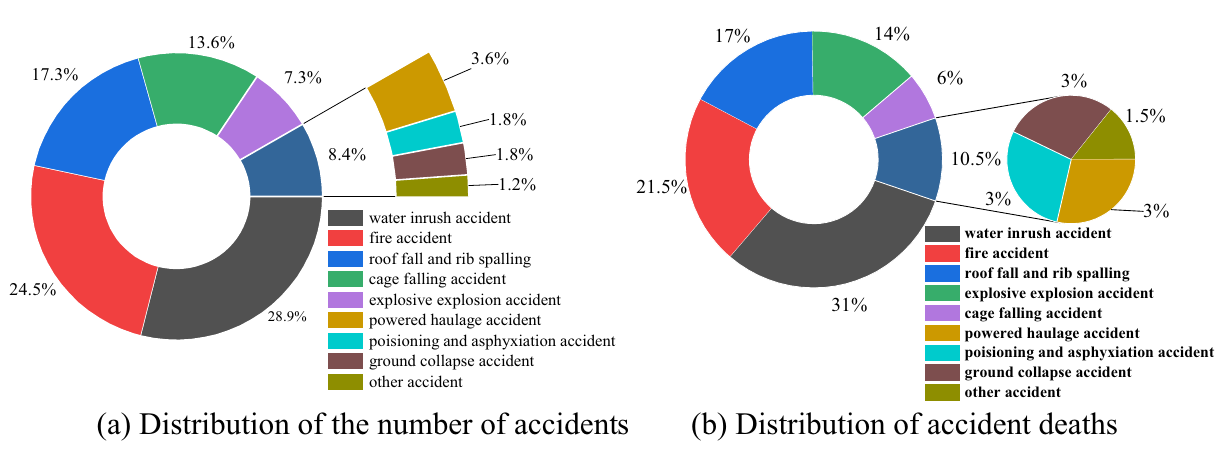
Figure 2. Distribution of the number of accidents and deaths of different accident types. ( a ) Distribution of the number of accidents. ( b ) Distribution of accident